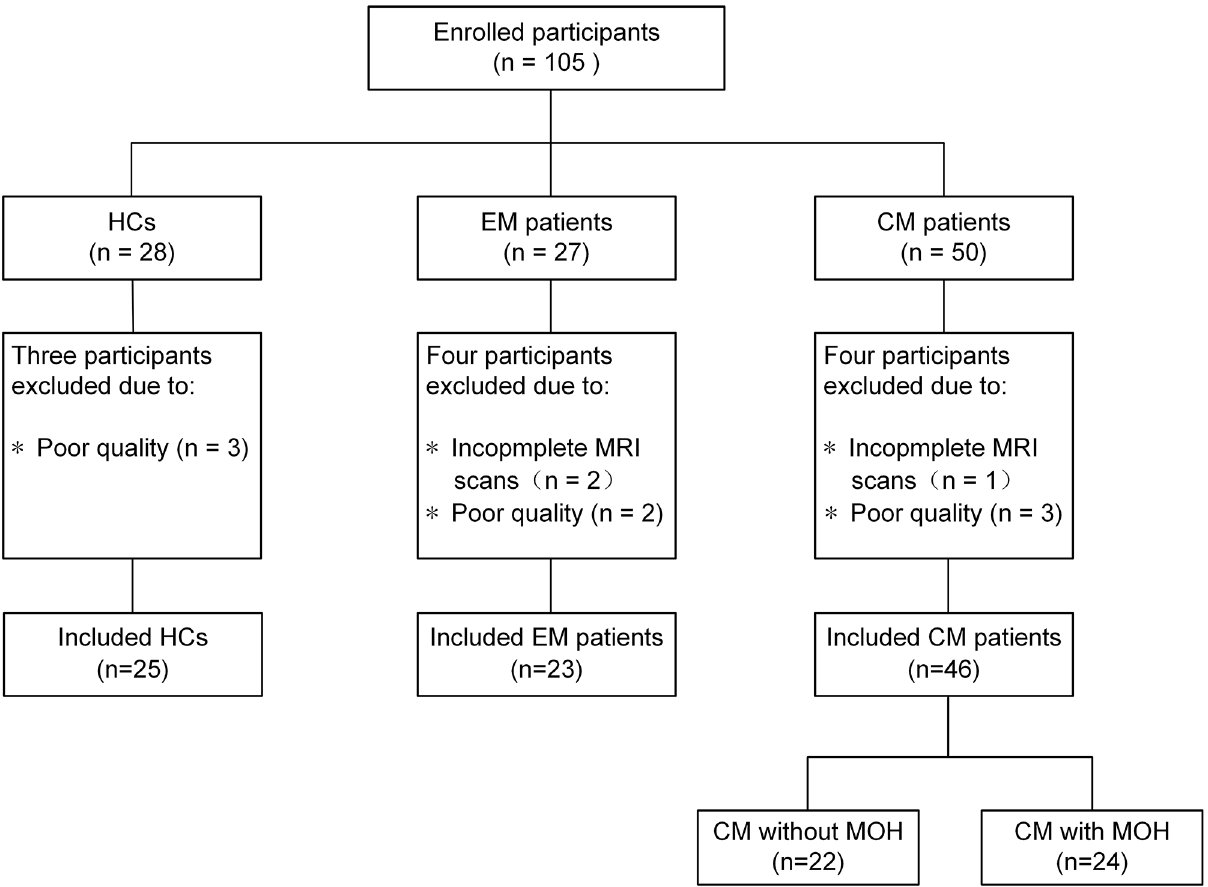
Fig. 1 Flowchart of the participant inclusion process Note: CM, chronic migraine; EM, episodic migraine; MOH, medication overuse